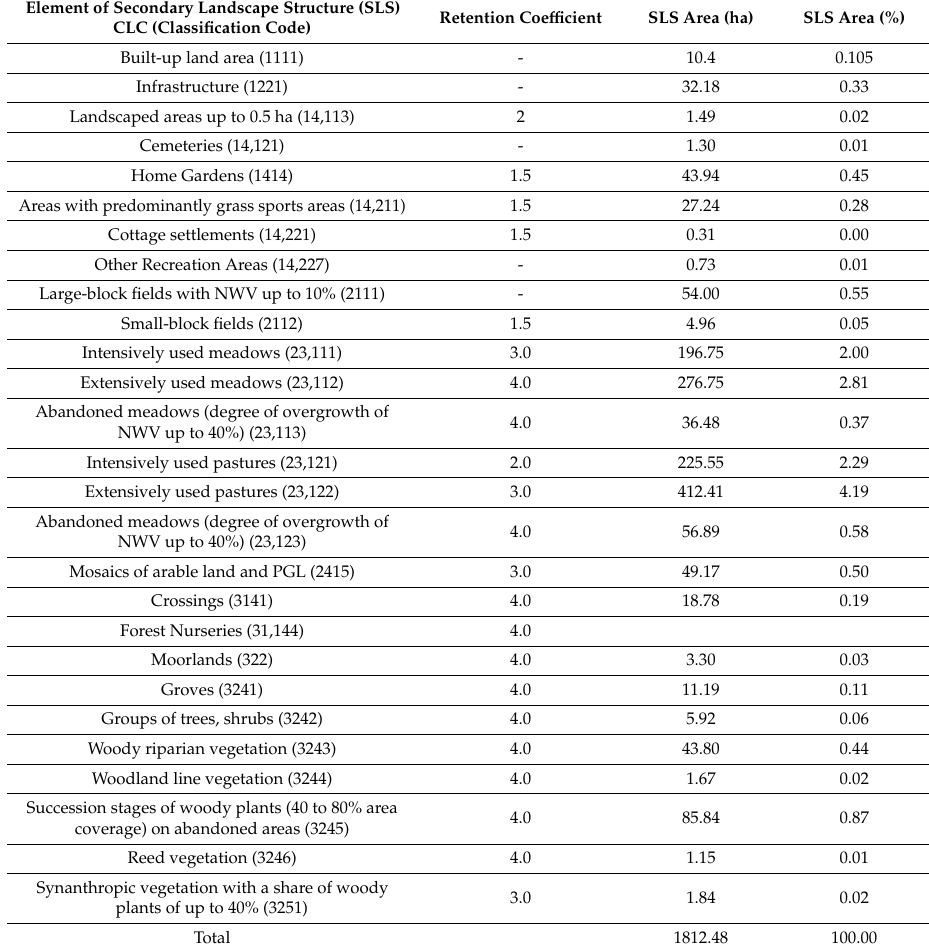
Table 2. Secondary landscape structure classes and their respective retention coe ffi cients in the study area of Liptovsk á